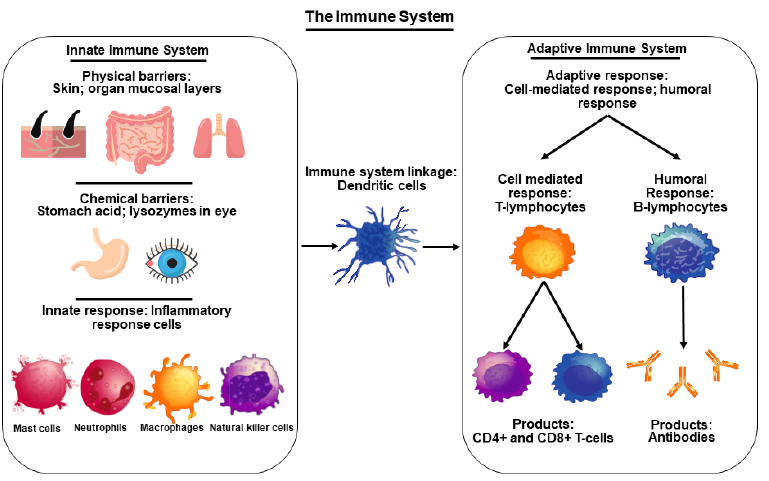
Figure 1. An overview of the immune system illustrating innate and adaptive immune system components. The innate immune system is composed mainly of physical and chemical barriers, and an initial inflammatory response made up of mast cells, neutrophils, macrophages, and natural killer cells. The adaptive immune response works through B- and T-lymphocytes creating a specialized and learned immune response to specific pathogens through antibodies and CD4+ and CD8+ cells. The adaptive and innate components are connected through dendritic cells that allow for the activation of the adaptive response once the innate system has recognized a threat to that organism.